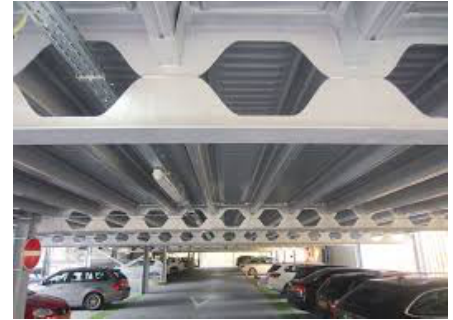
Figure 1: Castellated beams in parking building